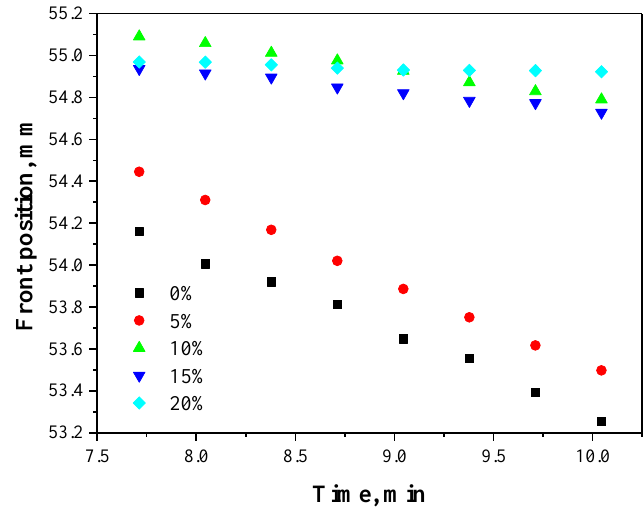
Figure 2. Migration front as a function of time.